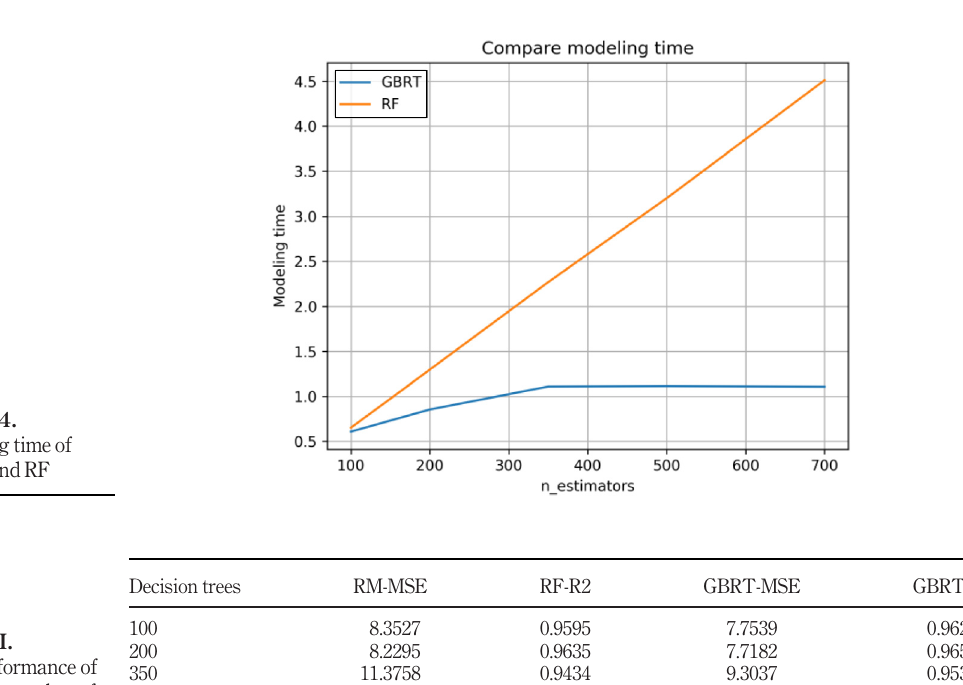
Table II. The performance of different number of base